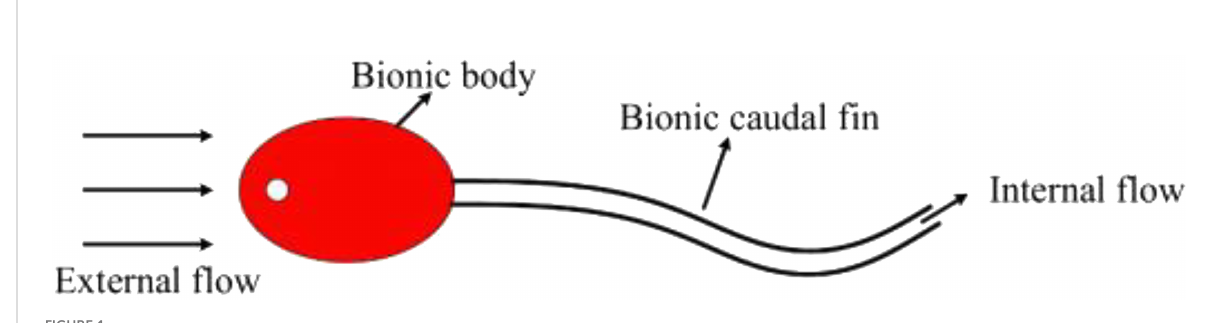
FIGURE 1 The underwater bio-inspired robot designed by Zhou and Dai (Zhou et al.,